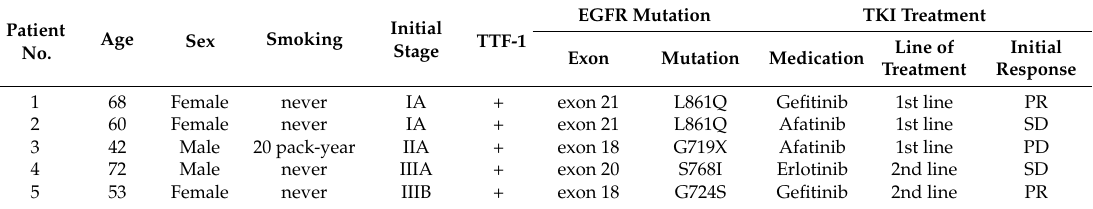
Table A2. Patients with stage I to III lung cancer harboring rare EGFR mutation. Patient No.